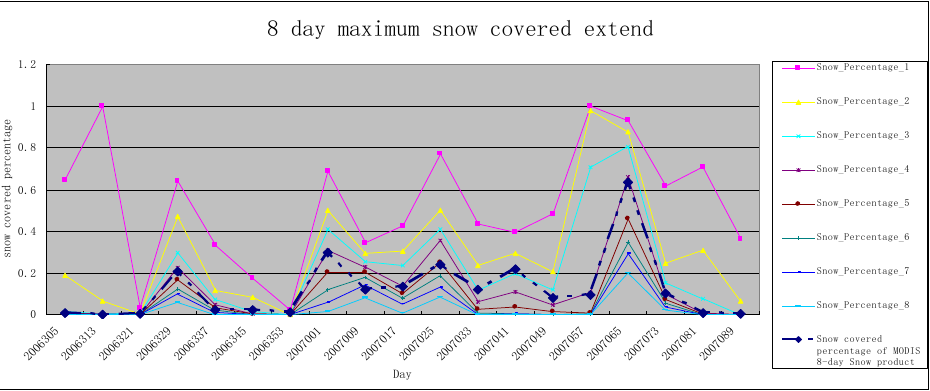
Figure 13. Statistical results of 8-day maximum snow covered extent. 8 day maximum snow covered